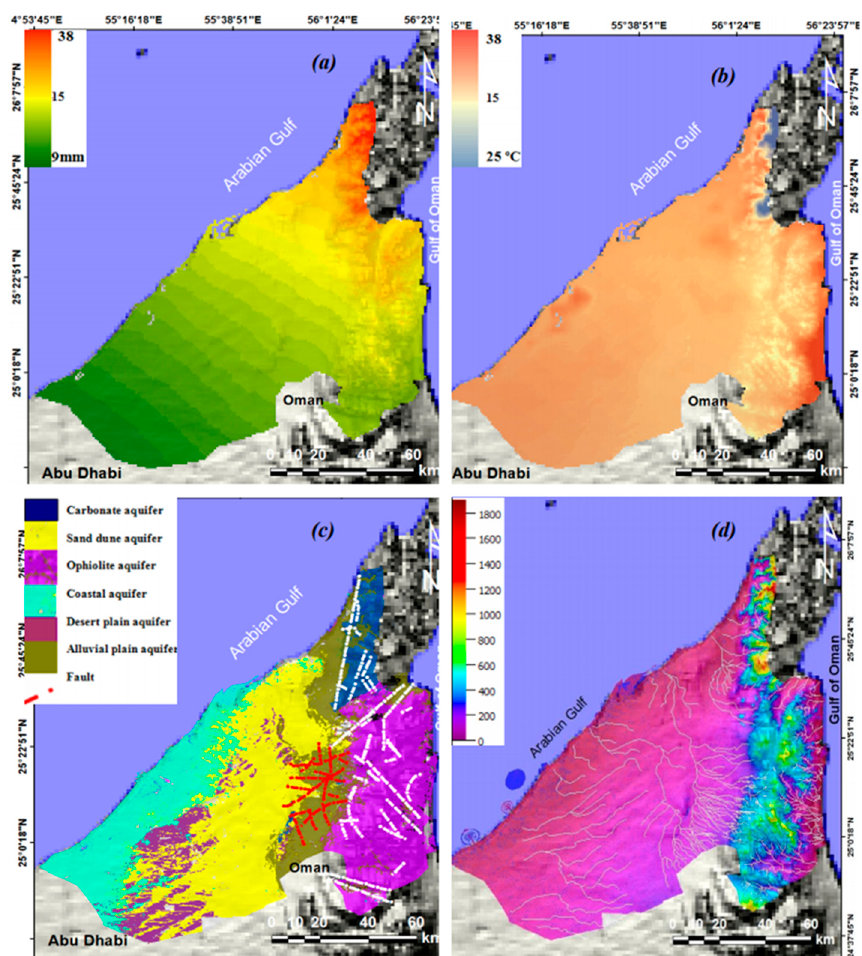
Figure 3. Maps of the spatial distribution of rainfall ( a ) and air temperature ( b ), and geohydrology ( c ), and wadi courses and palaeochannels generated from a DEM ( d ) of the study area.